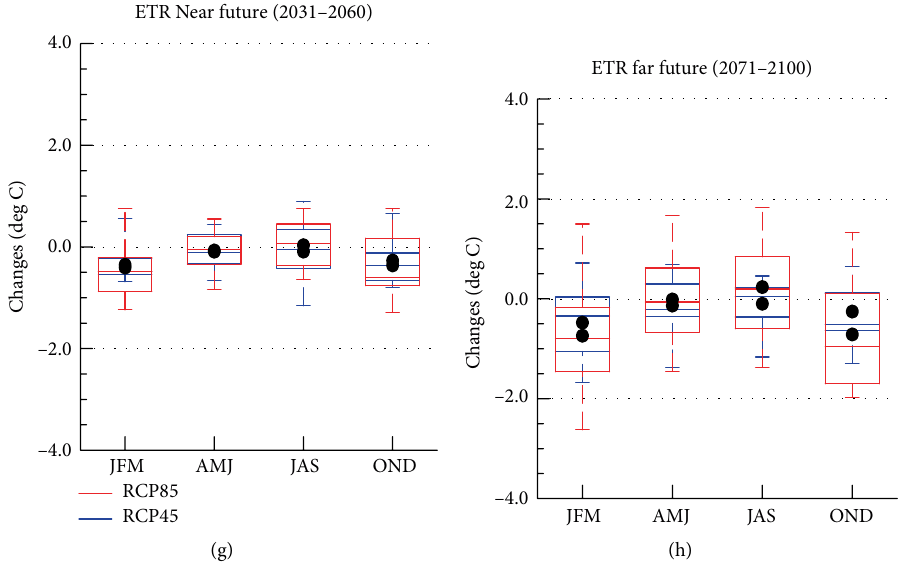
Figure 7: Assessment of CORDEX-Africa models agreement and inter-model spread on the projected changes for the extreme temperature indices during 2031–2060 (left) and 2071–2100 (right) periods under RCP4.5 (blue) and RCP8.5 (red) scenarios. Changes are estimated in (%) for HWFI, TX90P and TN90P and, in (°C) for ETR with respect to the mean value of the 1976–2005 period. Black dots indicate ensemble mean